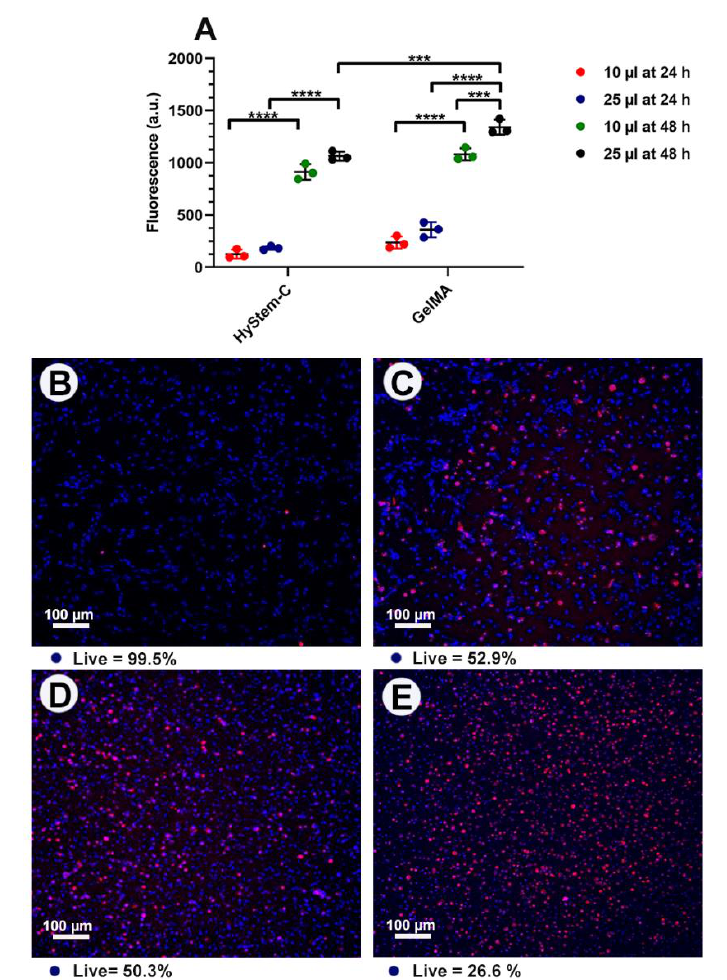
Figure 2. Top: ( A ) Graph showing cell viability of 25 and 10 µL construct sizes of both HyStem ® -C and GelMAat 24 h and 48 h. Bottom: Confocal images of live/dead cells. Live cells—blue, dead cells—red. **** p < 0.0001, *** p < 0.001, ( B ) HyStem ® -C 10 µL. ( C ) HyStem ® -C 25 µL. ( D ) GelMA 10 µL. ( E ) GelMA 25 µL.